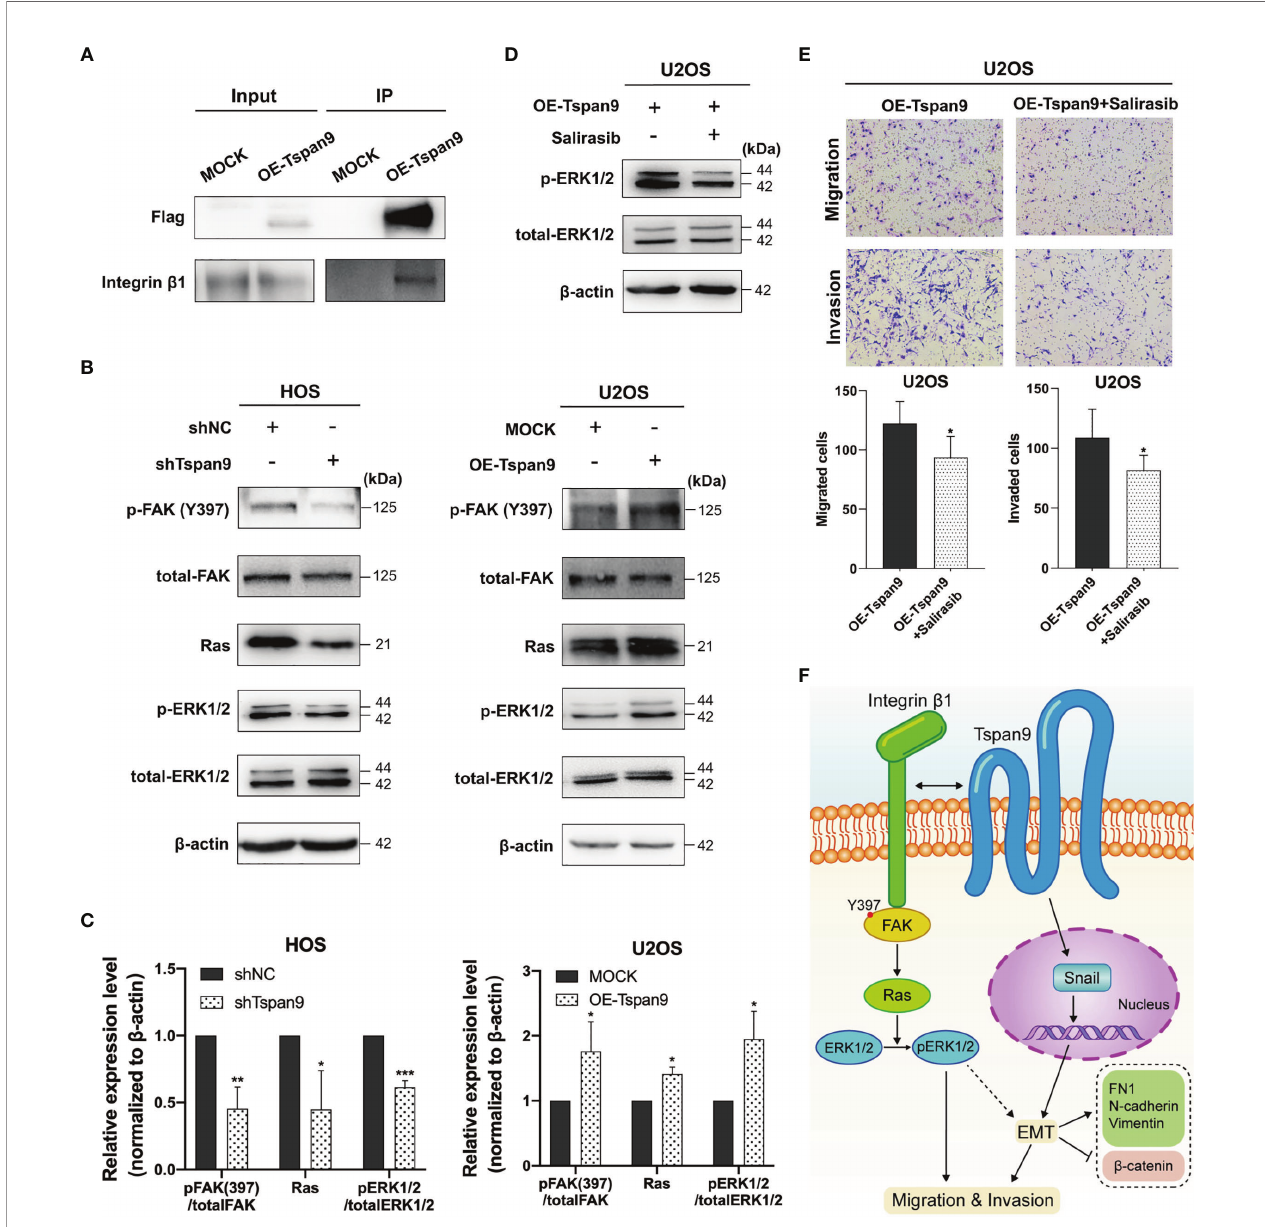
FIGURE 6 | Tspan9- b 1 interactions promote FAK-Src-Ras-ERK1/2 pathway signaling and OS metastasis. (A) Interactions between Tspan9 and integrin b 1 were detected in a co-IP assay. (B) FAK-Ras-ERK1/2 pathway proteins (FAK Y397 , total-FAK, Ras, pERK1/2, and total-ERK1/2) were analyzed via western blotting, with b - actin as a loading control. (C) Quanti fi cation of the Western blotting results presented in (B) . (D) Western blotting was used to assess Ras downstream signaling in OE-Tspan9 U2OS cells following Salirasib treatment (50 m M). (E) Following treatment with Salirasib (50 m M), OE-Tspan9 cells were analyzed in migration and invasion assays, with representative cells being shown. (F) Schematic presentation of mechanism underlying Tspan9-mediated OS metastasisis. All analyzes were repeated two or three times. Data are means ± SD. * P < 0.05; ** P < 0.01; *** P <